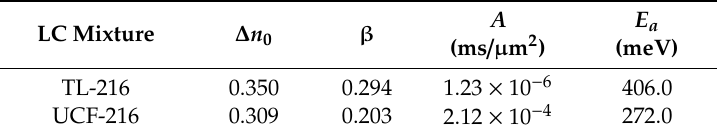
Figure 2. Temperature-dependent birefringence of TL-216 and UCF-216 at λ = 633 nm and 1 kHz. Dots are measured data and solid lines are fitting curves with Equation (1). The fitting parameters are listed in Table 2. Table 2. Fitting parameters obtained through Equations (1) and